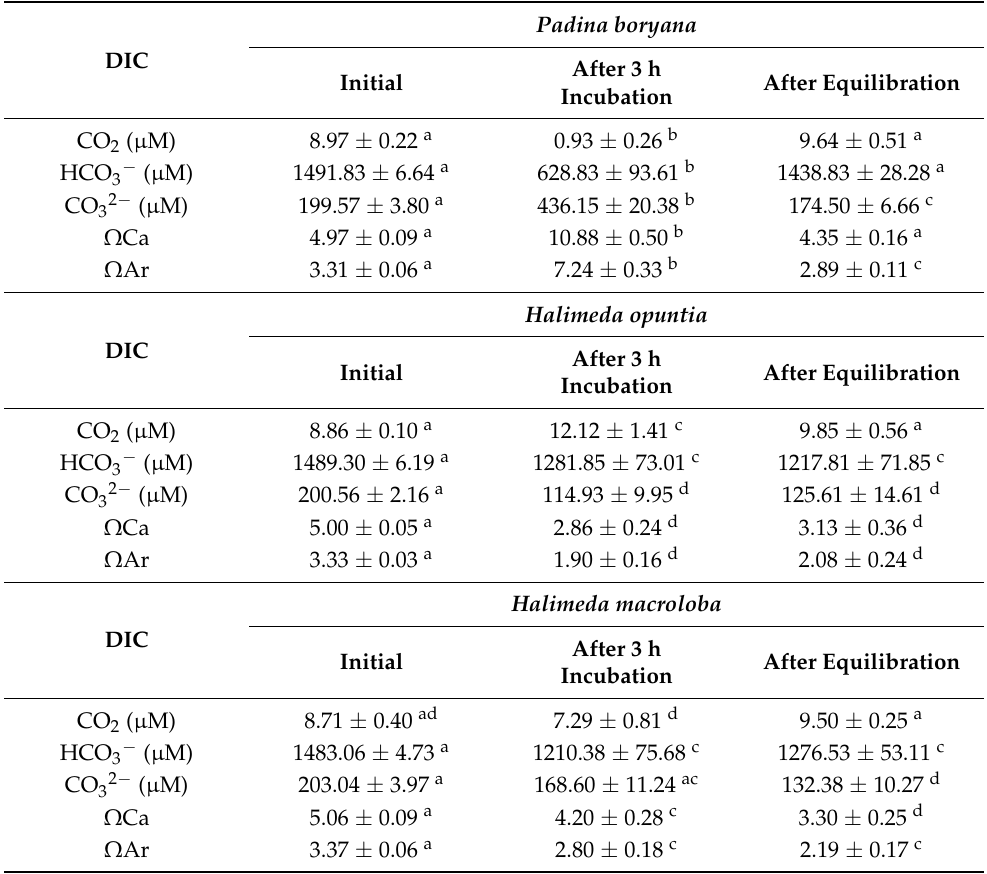
Table 2. A summary of seawater carbonate chemistry before an incubation with Padina boryana , Halimeda opuntia and Halimeda macroloba (initial), after 3 hours of incubation and after equilibration with air. The values presented were calculated from the average total alkalinity and pH (see Figure 2) using CO 2 sys.xls program (version 2.3). Data are means ± SE (n = 9). Different uppercase letters indicate statistical difference (Fisher’s LSD test, p < 0.05). Padina boryana DIC After 3 h Initial